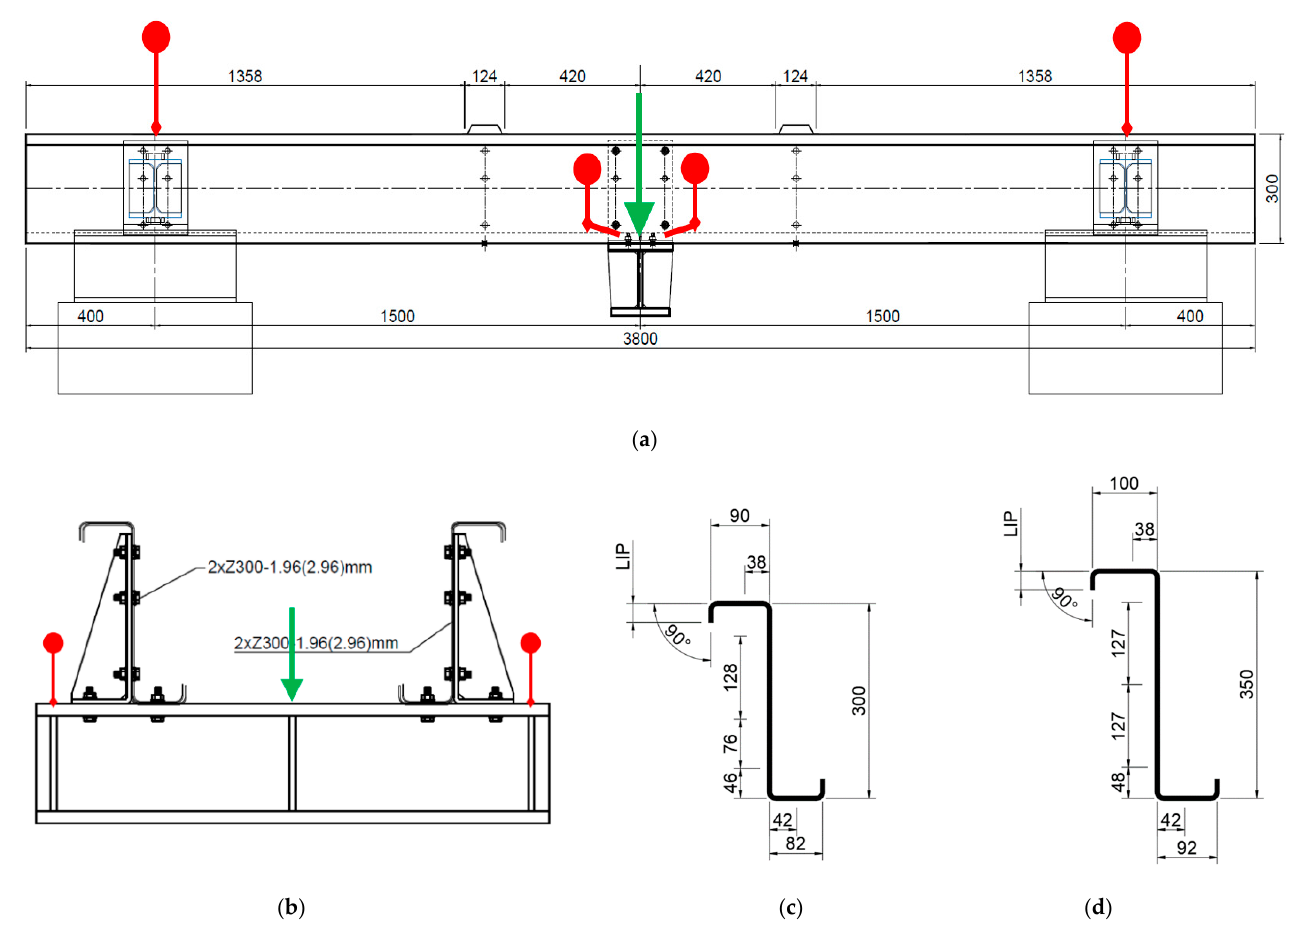
Figure 3. Scheme of the experimental set-up: ( a ) side view, ( b ) cross section for purlins Z300, and dimensions of purlins ( c ) Z300 and ( d ) Z350—all in mm.